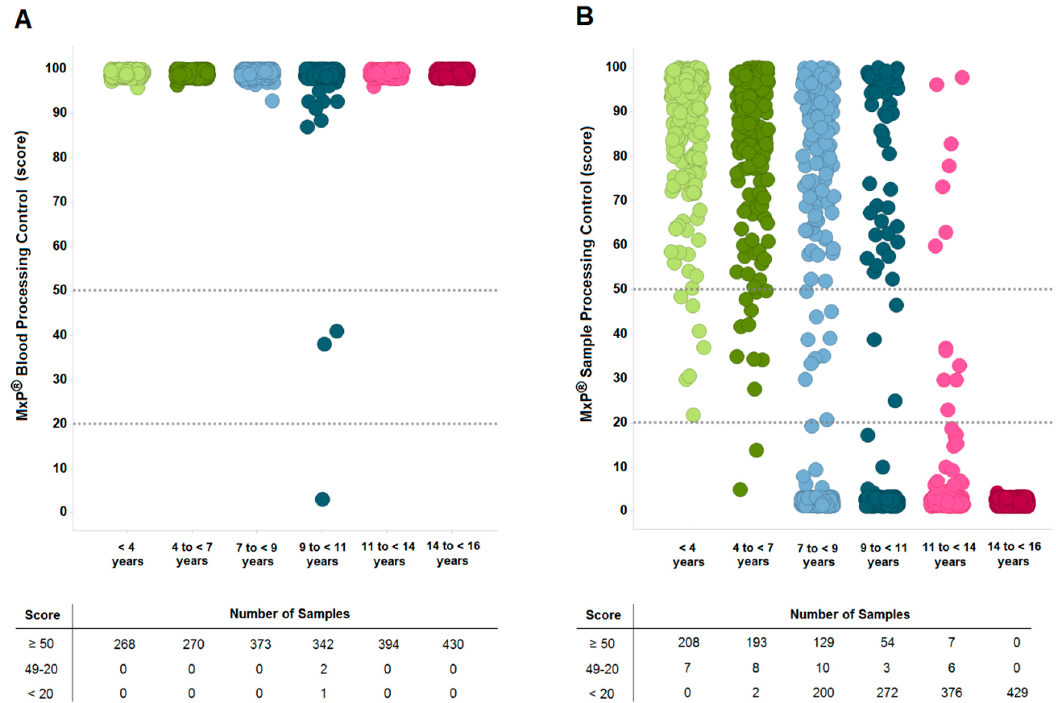
Figure 4. Sample quality assessment by the MxP Biofluids Quality Control assay: ( A ) MxP Blood Processing Control and ( B ) MxP Sample Processing Control were calculated in score for each sample, and the cut-offs were set to ≥ 50 for high-quality samples and <20 for low-quality samples. Please note that quality scores are not displayed for all samples as metabolite levels needed for the assay were in some cases below the limit of detection of the analytical method.